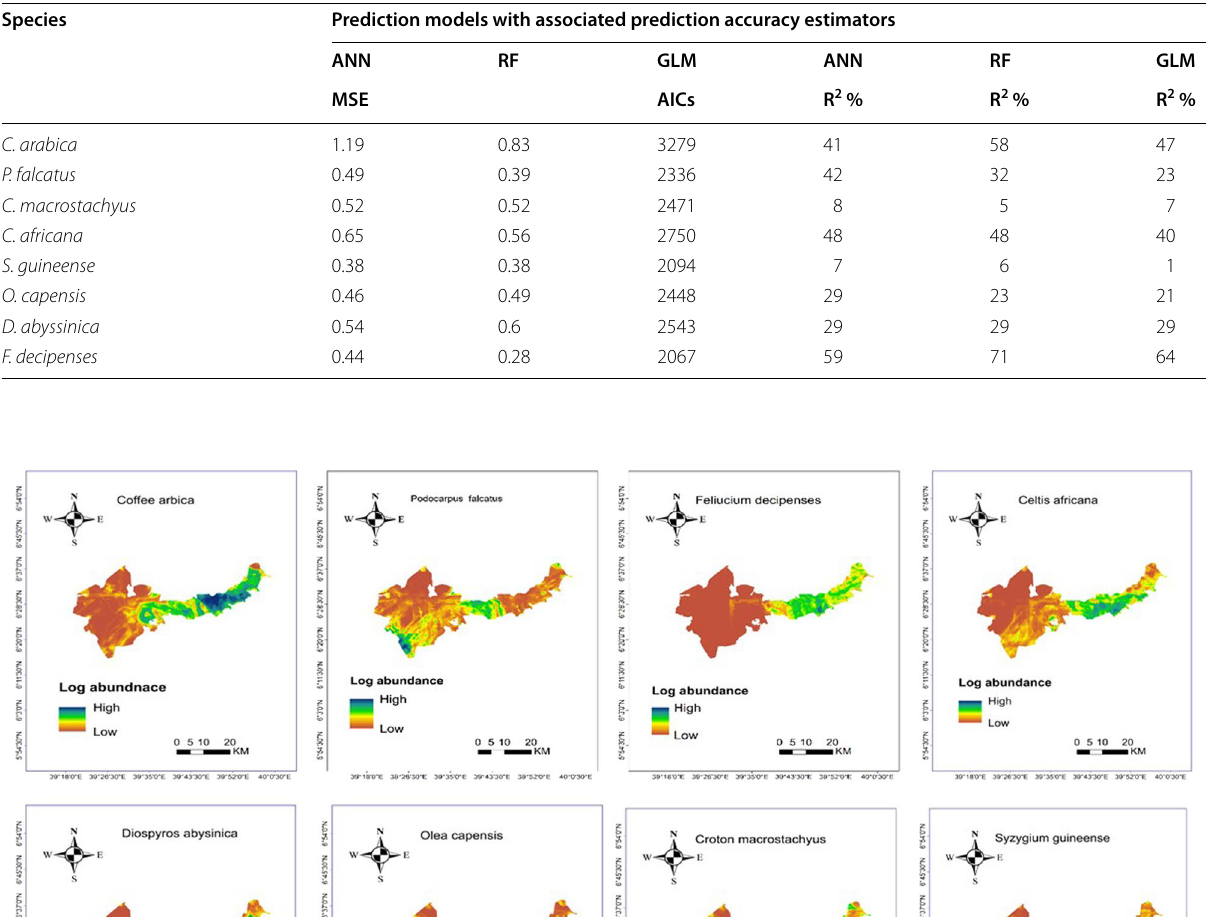
Table 5 Prediction accuracies of the ANN, RF, and GLM models using MSE, AICs and R 2